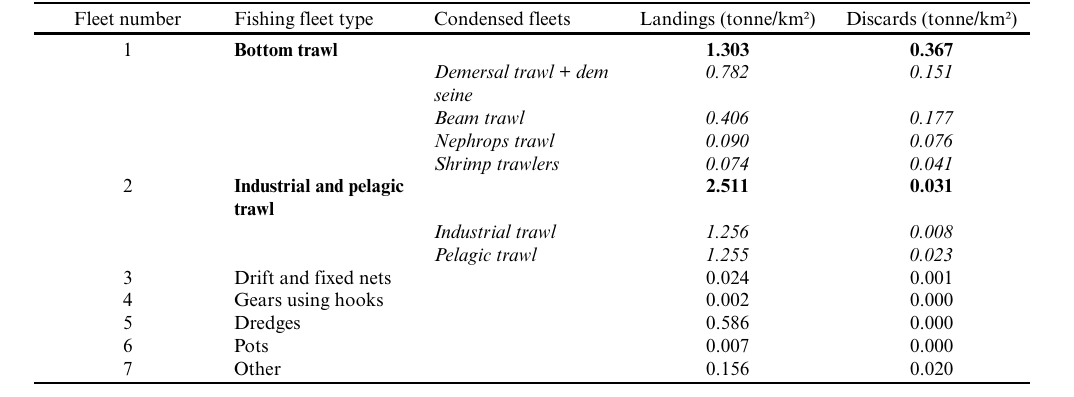
Table 3. Fishing fleet structure, landings, and discards for the condensed marine spatial planning challenge North Sea Ecopath model. Fleets that include more than one of the fleets from the original North Sea model are in bold font and their components are in italics.